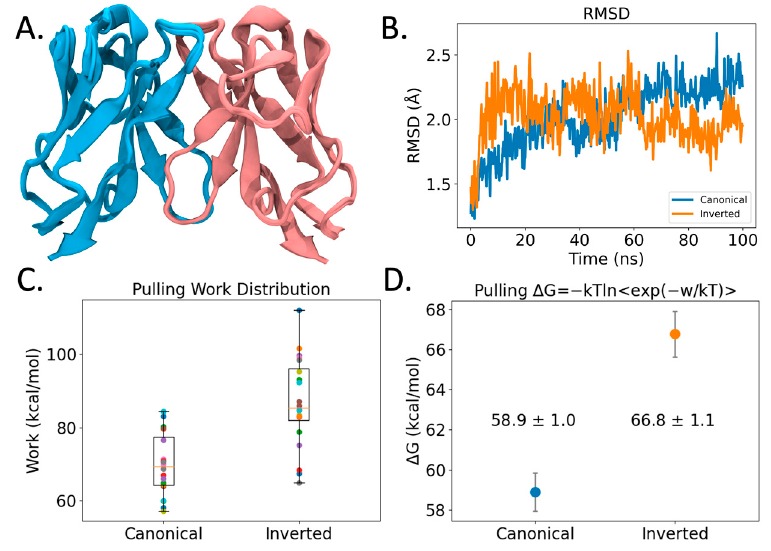
Figure 4. Modeling of VL-VL binding interface. ( A ) Structural overlay of 25 VL-VL binding complex structures predicted by AlphaFold2 in the canonical configuration. Blue and pink coloring identifies different VL Ig domains. ( B ) RMSD profile of VL-VL complex showing stability across the Molecular Dynamics (MD) simulation. ( C ) Pulling work required to pull VL-VL complexes apart using Steered Molecular Dynamics (SMD). Shown are boxplots and points of all 20 replicas in different colors. ( D ) VL-VL binding free energies of SMD simulations from ( C ) computed using Jarzynski’s inequality. Coloring denotes Canonical (blue) and Inverted (orange) conformation binding free energies. Error bars represent 95%